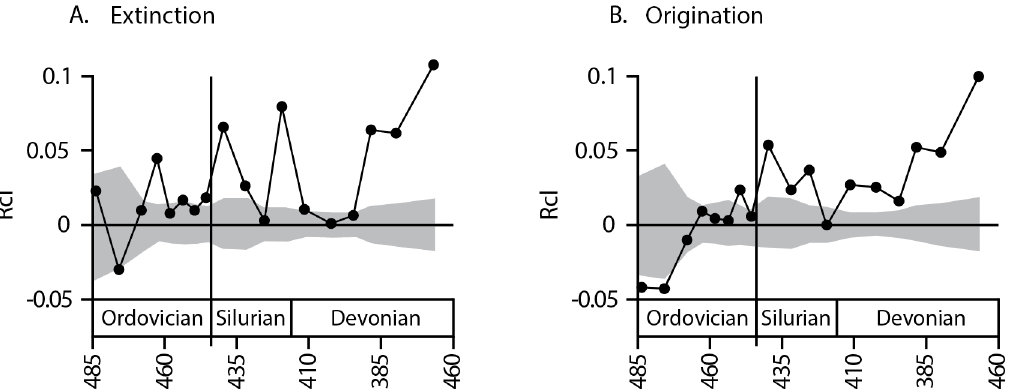
Fig 1. Taxonomic clustering of A. extinction and B. origination for brachiopod genera within families for the Ordovician through the Devonian. Grey region represents 95% confidence intervals around the null distribution of Rcl values determined through